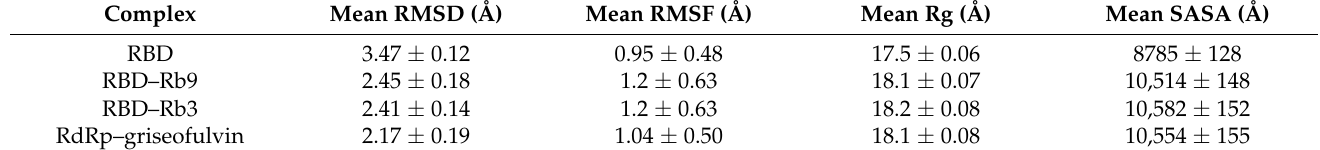
Table 5. The average of RMSD, RMSF, Rg, and SASA for RBD during the last 20 ns of MD simulations. PubChem IDs of derivatives Rb9 and Rb3 are 125429633 and 56950846, respectively.